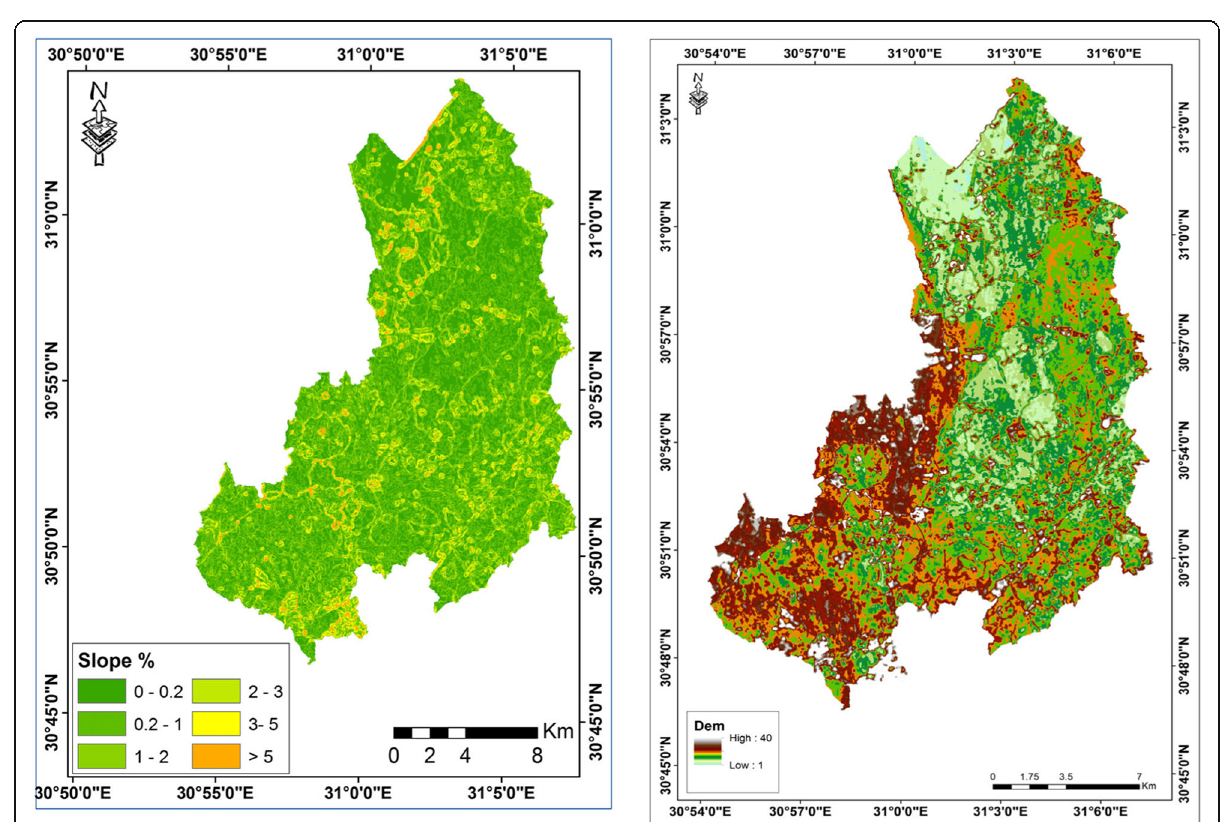
Fig. 4 Spatial distribution of DEM and the slope at the catchment